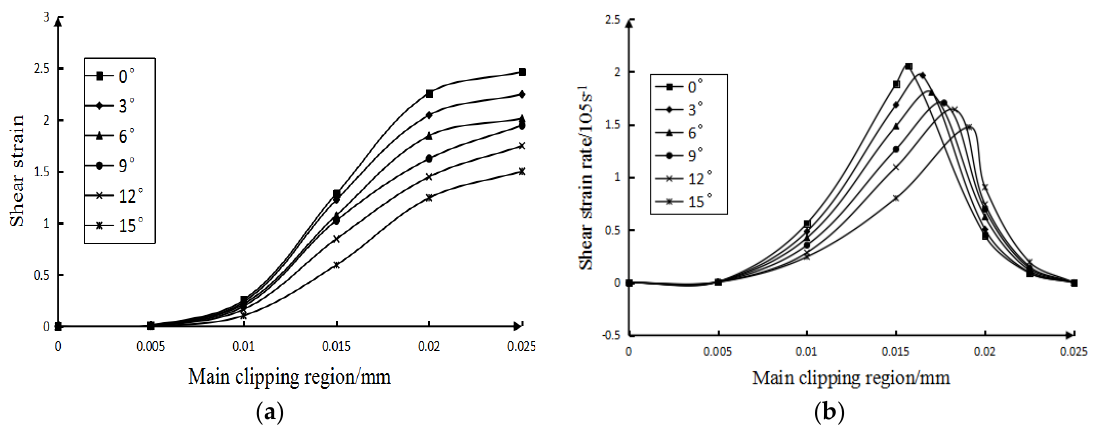
Figure 6. The influence of tool rake angle. ( a ) The influence of tool rake angle on shear strain ( b ) The influence of tool rake angle on shear strain rate. ( b ) The influence of tool rake angle on shear strain